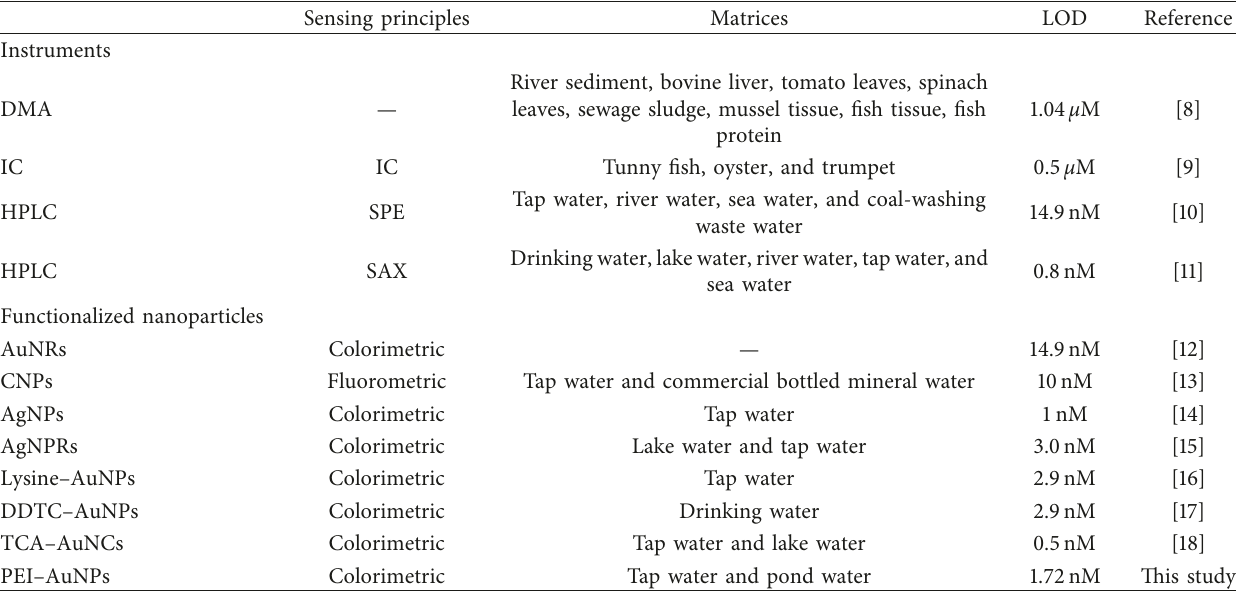
Table 3: Comparison of previously reported instrumental methods and nanoparticle assay methods proposed for the detection of Hg 2+